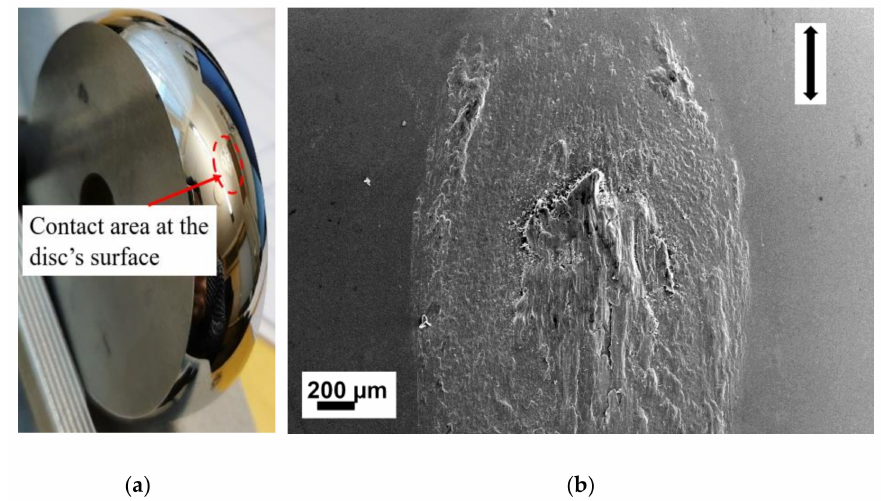
Figure 8. The typical worn surface of the discs after the occurrence of galling: ( a ) image of the disc and ( b ) SEM image of the contact area.